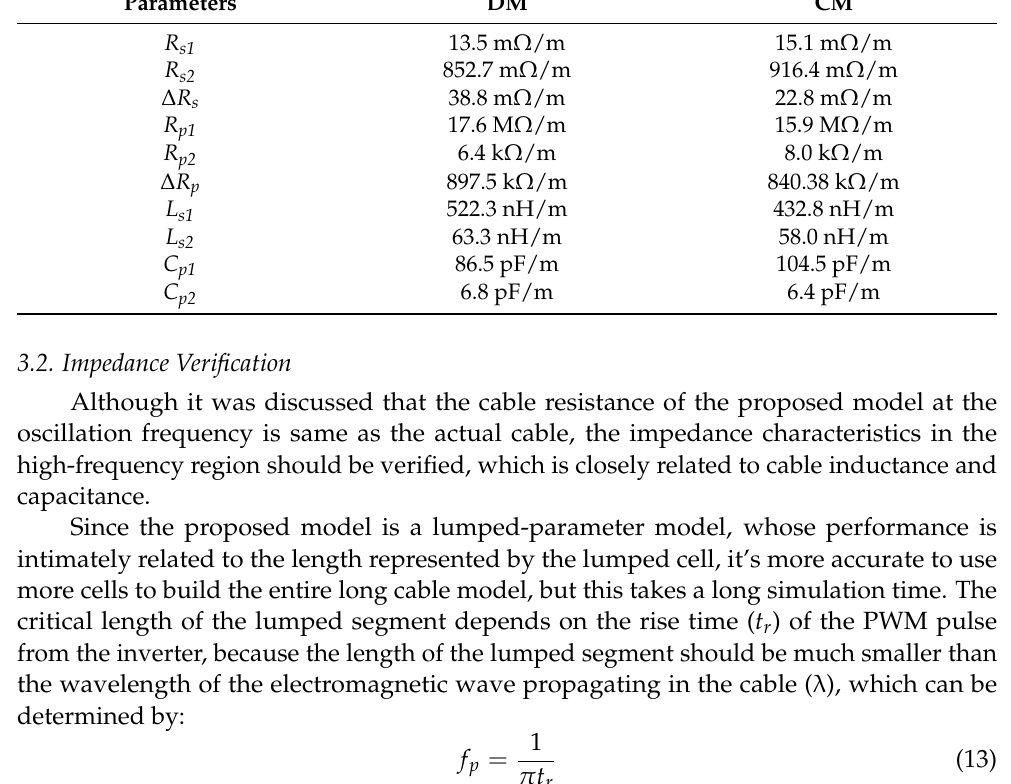
Table 5. Per-unit parameters of the proposed model.